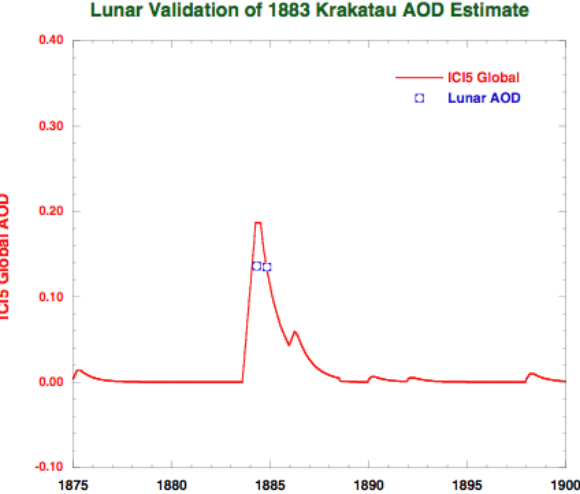
Figure 8. Comparison of reconstructed AOD and Re ff for new ice core reconstruction (ICI stands for “ice core index”); note that R e ff is plotted on reverse scale to enable easier comparison.